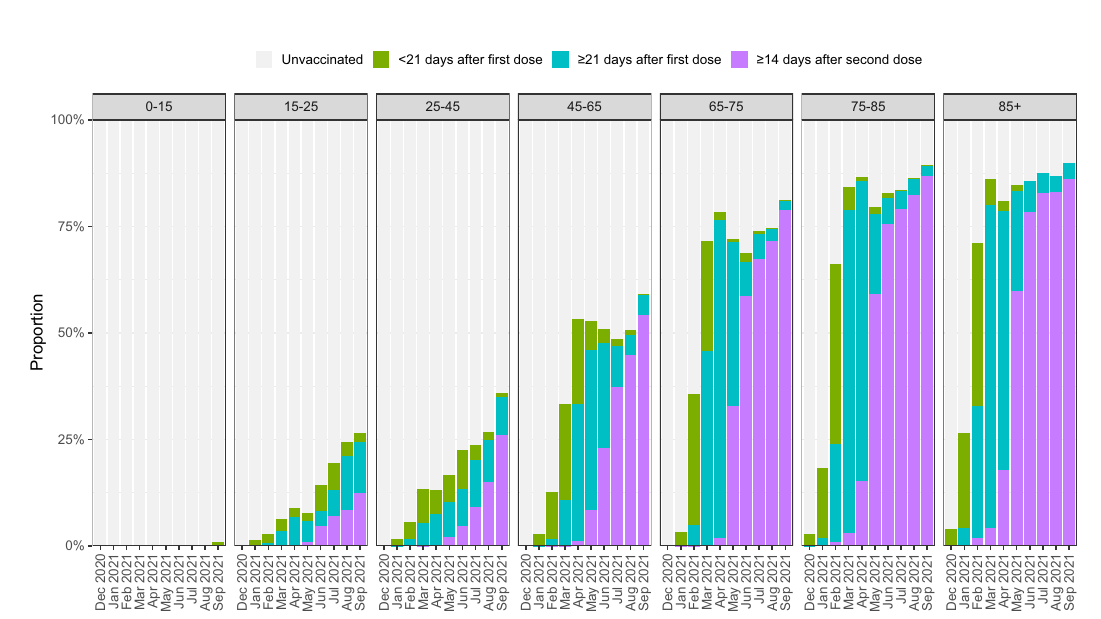
Fig. 2 | Vaccination status of hospitalised individuals, by month of admission and age group. December 2020 to September 2021. n =166,893 individuals with vaccination status